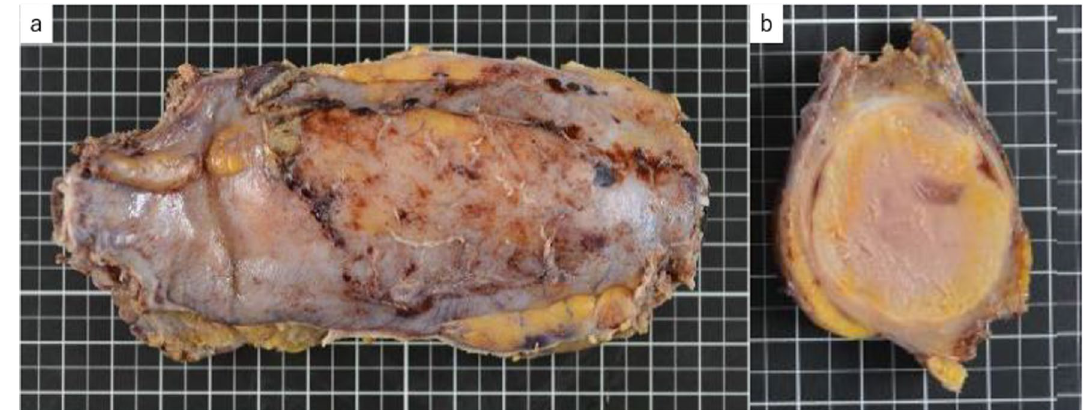
Fig. 2 Gross appearance of the resected specimen. a Gross appearance resected specimen combined with 7th–9th ribs and intercostal muscle resection after fixation. b Cut surface showed bimorphic of gray-white and pale-yellow components with a heterogeneous